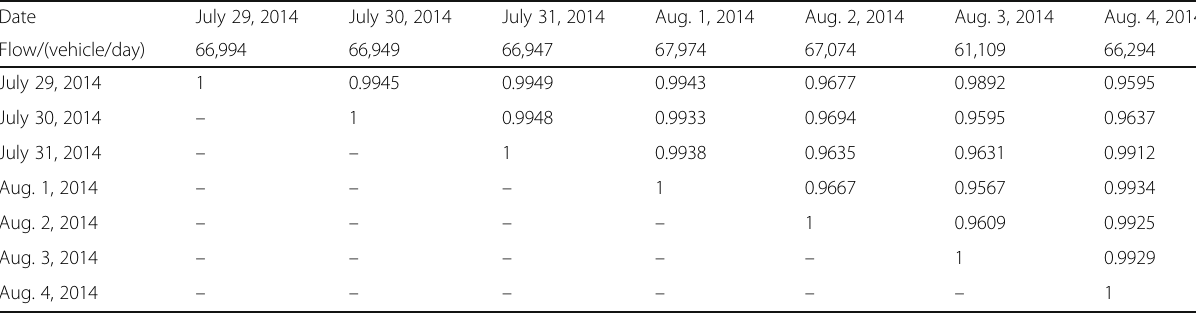
Table 1 The daily total flow of the intersection and 15-min flow correlation